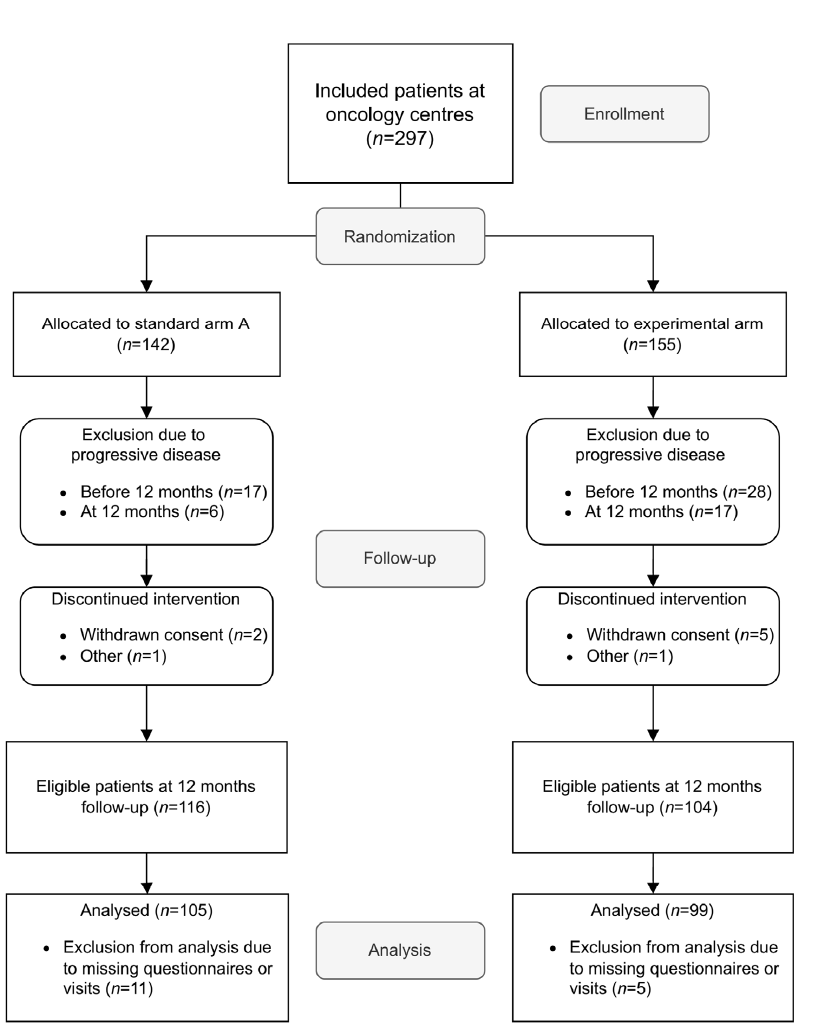
Figure 1. CONSORT diagram. Patients included at all TRIM-study oncology sites between June